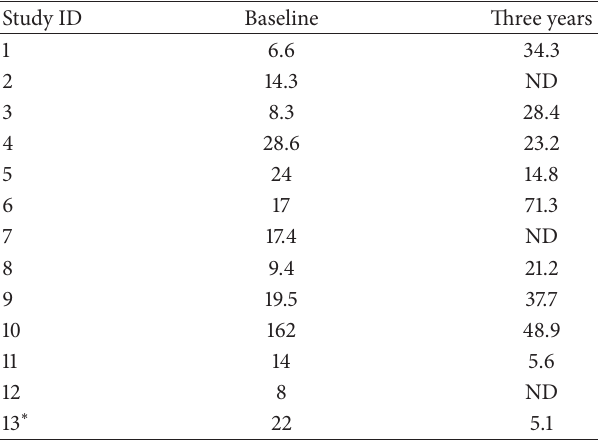
Table 2: Compliance (mL/cm H